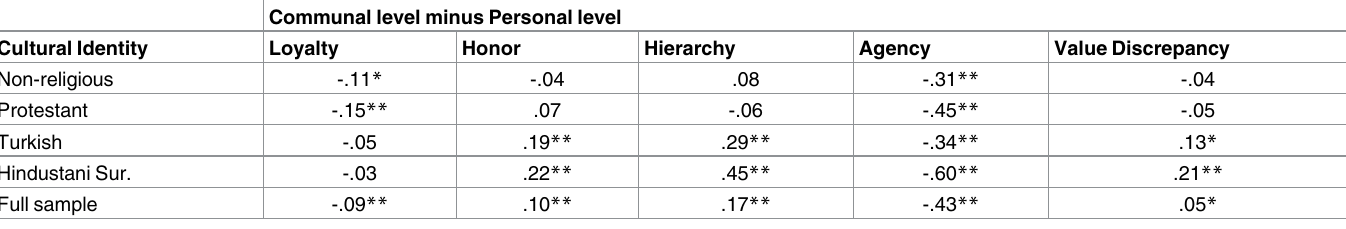
Table 10. Value discrepancy: CCS differences between Community and Personal